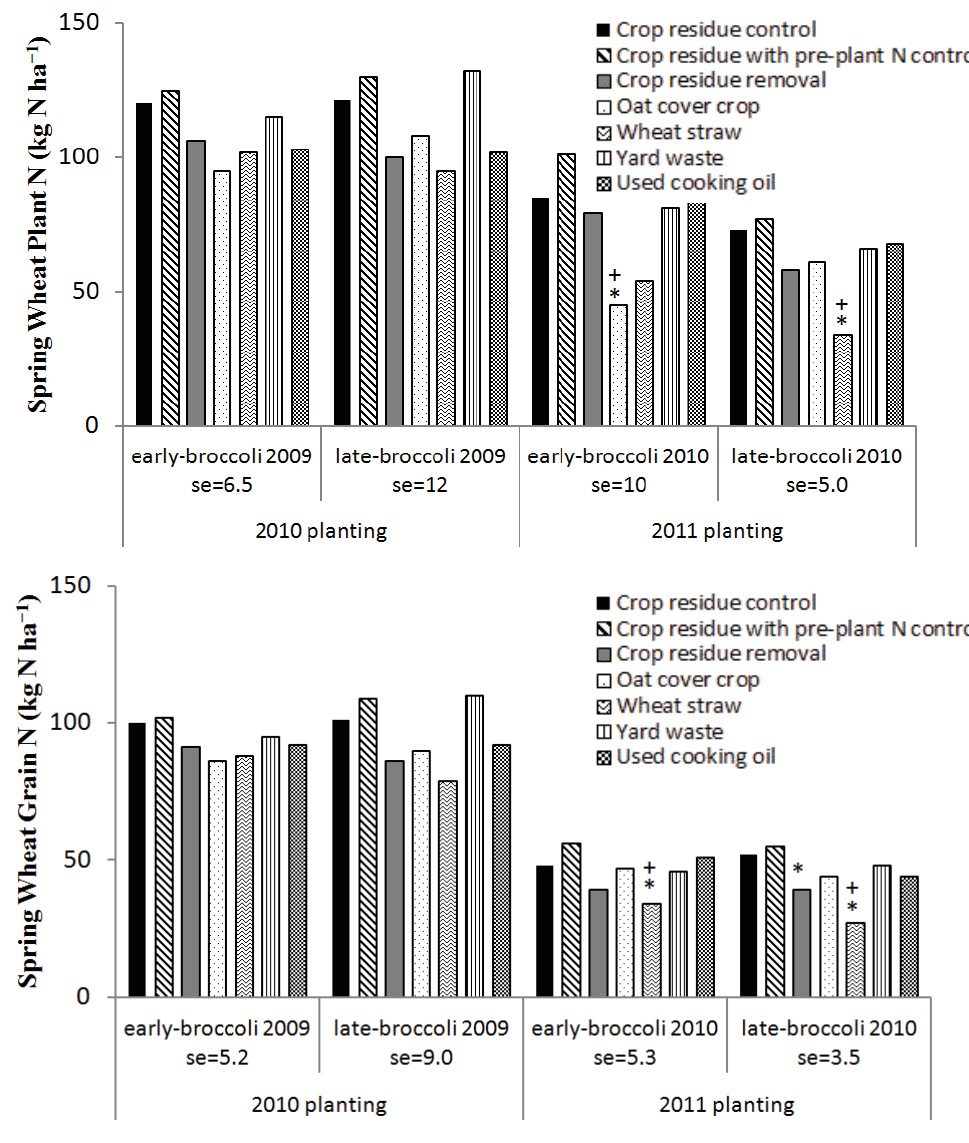
Figure 2. The N content (kg N ha (cid:237)(cid:20) ) of spring wheat plant biomass (grain + straw) and grain in 2010 and 2011, as affected by the previous years’ treatments in the early- and late-broccoli systems. Symbols denote a significant difference ( P < 0.05) compared to the crop residue control * or the crop residue with pre-plant N control +, based on a multiple means comparison with a Dunnett-Hsu adjustment. The se values represent the standard error of the